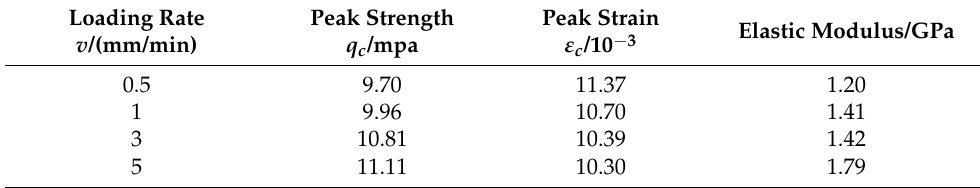
Table 1. Peak Strength, Strain, and Elastic Modulus of Specimens under Uniaxial Condition. Loading Rate